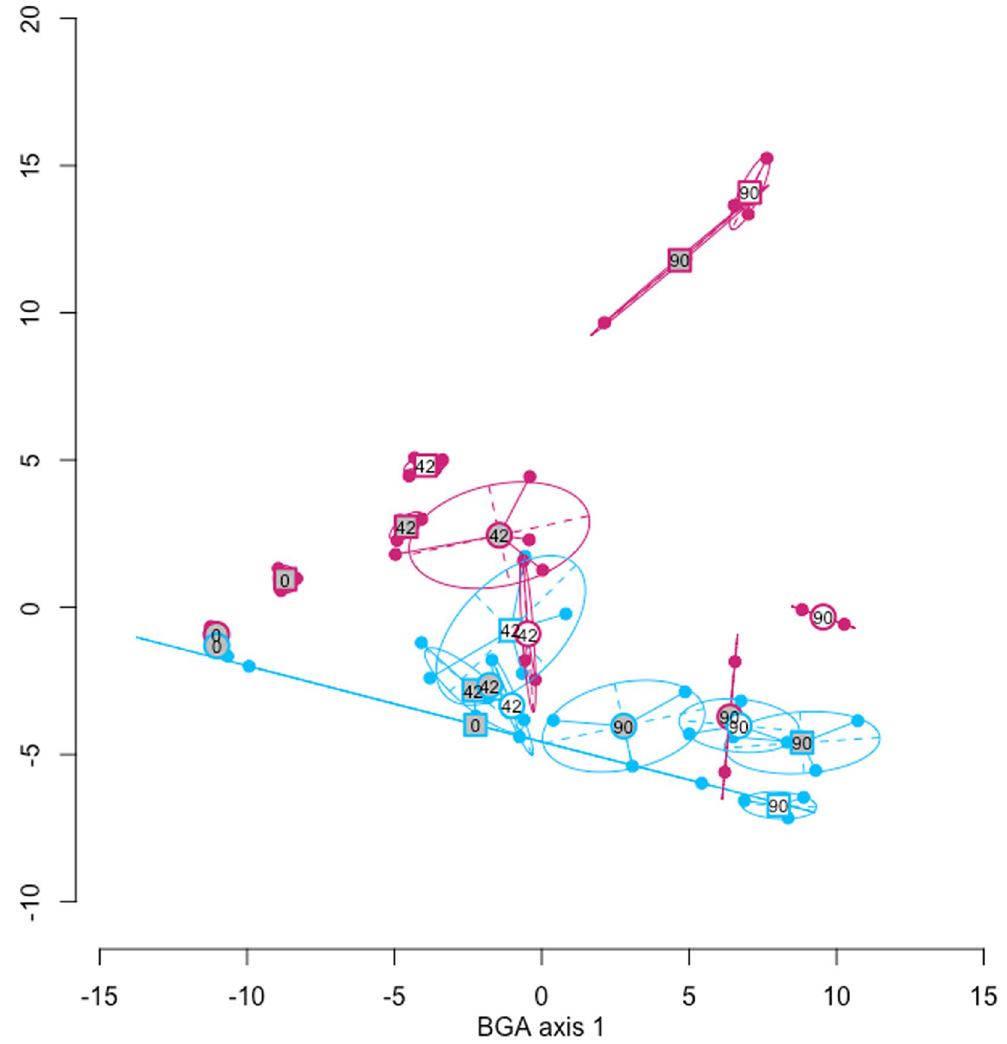
Figure 4. BGA ordination plot of bacterial community ARISA profiles. The large symbols indicate the group centroids and the small symbols the individual samples. The pink symbols are the microbial communities from the silty soil and the blue symbols the microbial communities from the sandy soil. The square centroid symbols indicate the silty soil and the round centroid symbols the sandy soil. The number in the centroid symbols indicate the day of analysis. The circles are envelops that incorporate 66% of the individual samples in a given